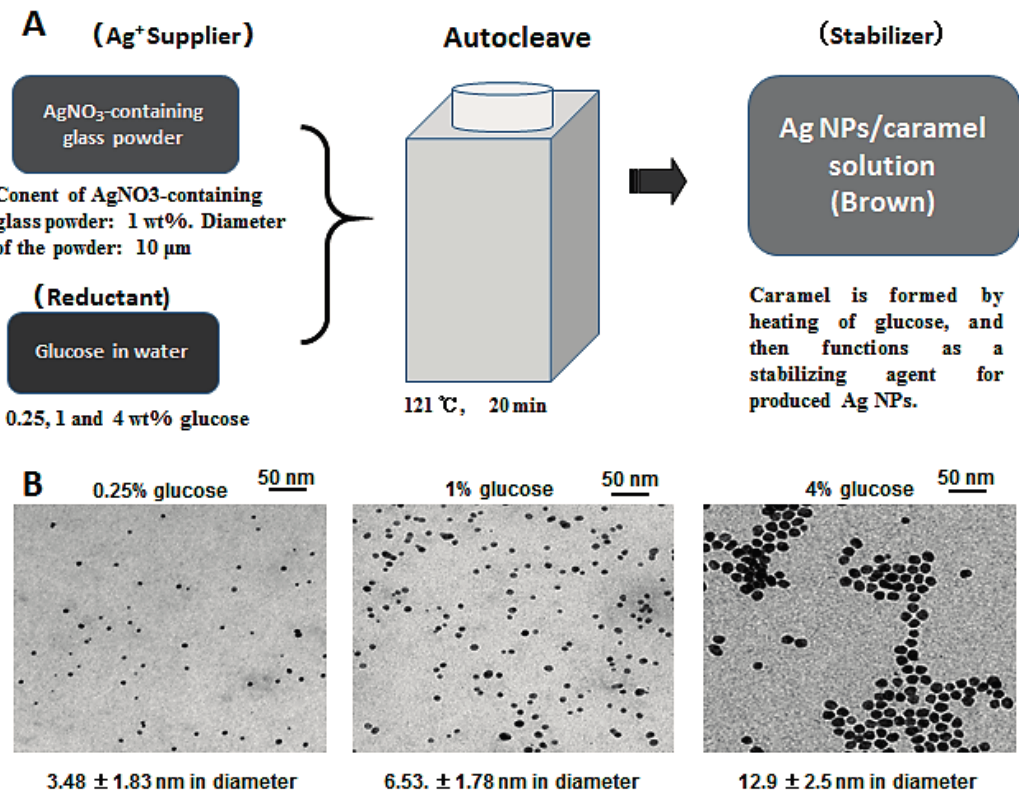
Figure 1. Synthesis of silver nanoparticles. ( A ) Environment-friendly processes were used to produce Ag NPs within a narrow size distribution; ( B ) Diameters of Ag NPs were controlled by glucose (reductant) concentrations. Currently, 0.8% glucose is used as a reductant, in which the generated Ag NPs are 5.17 ± 1.92